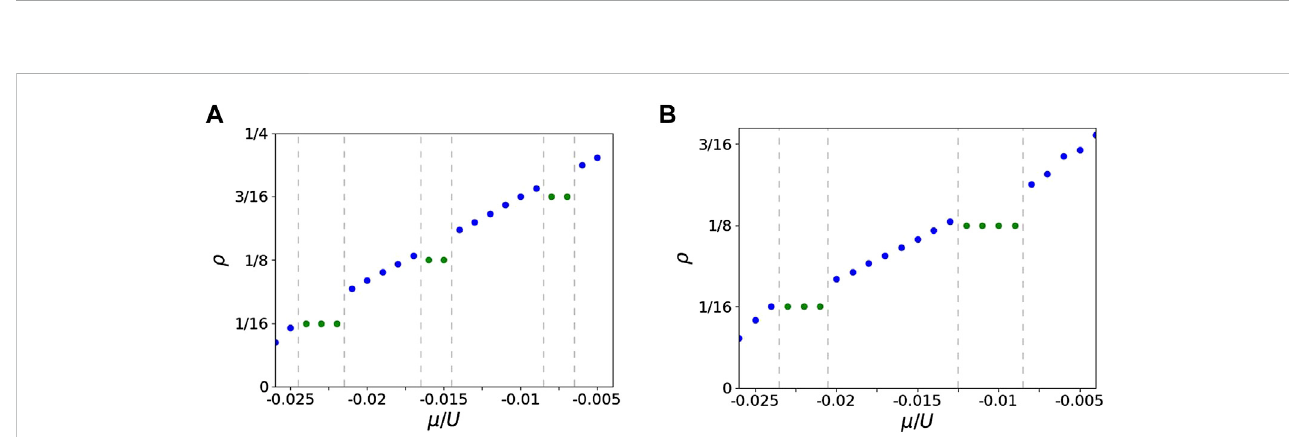
FIGURE 5 Compressibility plot: ρ as a function of μ / U for α = 1/4 with dipolar interaction strengths (A) V = 2 J = 0.02 U and (B) V = 5 J = 0.05 U . Green color dots represent the incompressible states, and the super fl uid states are identi fi ed with blue color dots. The dashed gray line is a guide to the eye, separating the super fl uid and incompressible state regimes. This plot is obtained using the CGMF method with the 4 × 4 cluster for a 12 × 12 lattice with pbc along both the directions.